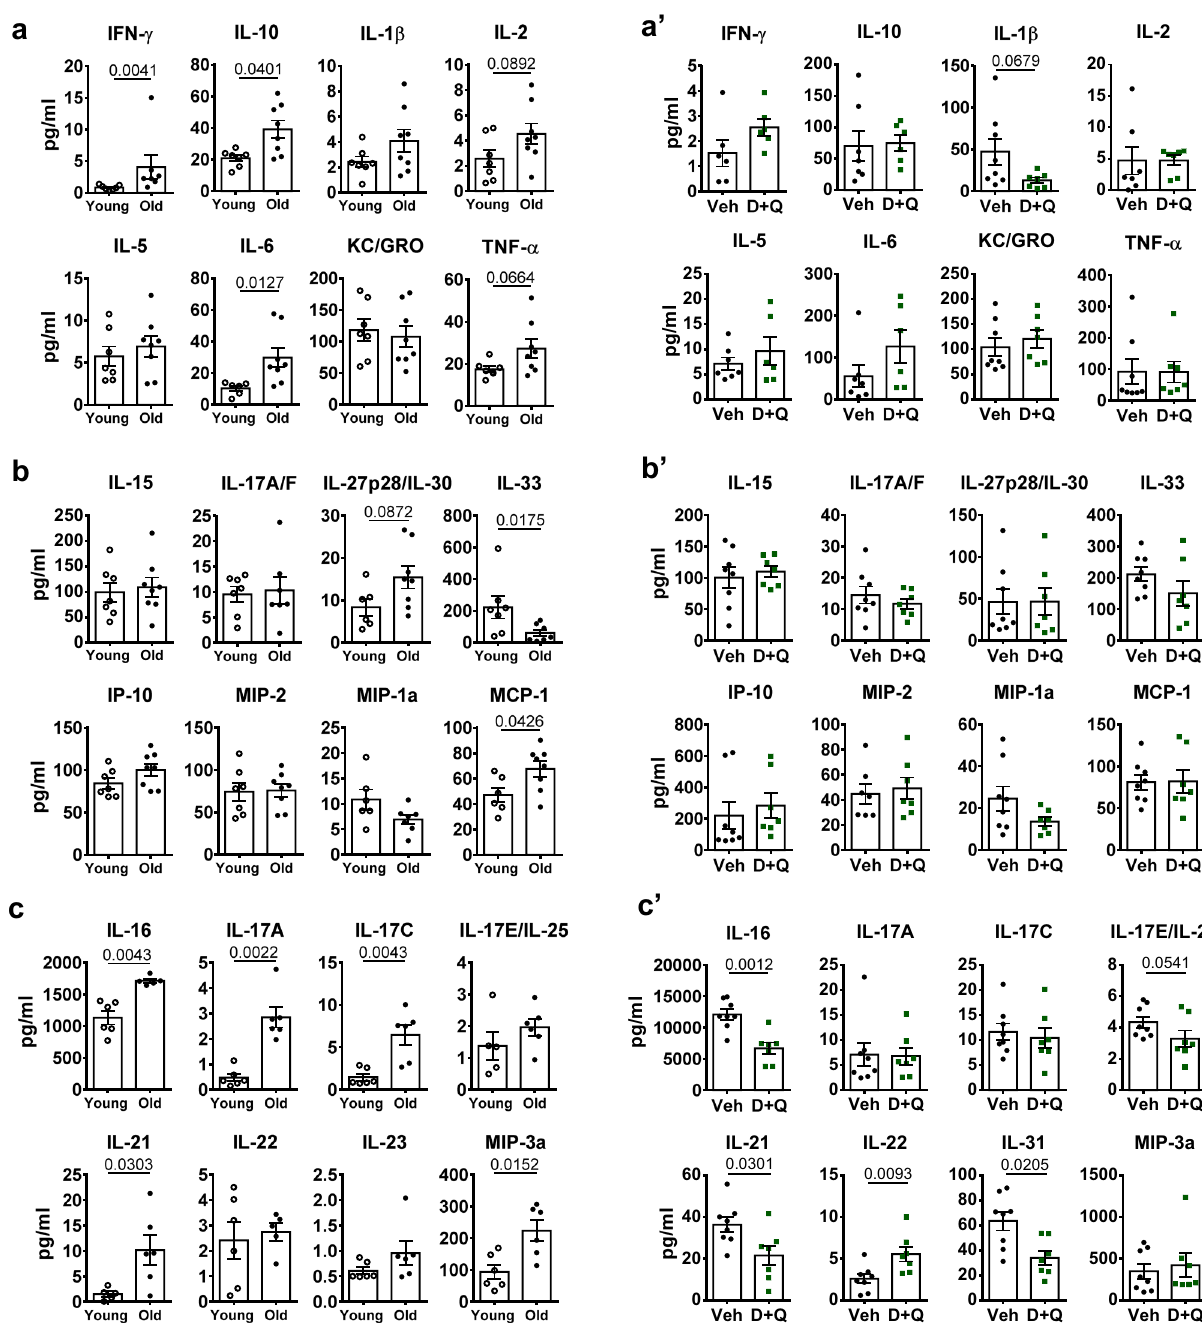
Fig. 7 D + Q treatment prevented the age-associated systemic increase in proin fl ammatory molecules, cytokines, and Th17-related proteins. Multiplex analysis of the main ( a – a ’ ) proin fl ammatory molecules, ( b – b ’ ) cytokines, and ( c – c ’ ) Th17-related proteins in plasma of young (6 – 12 M, n = 7), old (23 M, n = 8), Veh-14 – 23 M ( n = 8), and D + Q-14 – 23M ( n = 7) groups. Two-tailed t -test or Mann – Whitney test were used as appropriate. Data are represented as mean ± SEM. Source data are provided as a Source Data fi treatment duration cohorts (Supplementary Fig. 11a, b). Note- worthy, unlike in the intervertebral disc, immunohistochemistry analyses of senescence markers p16 INK4a , p19 ARF , and p21 in the knee joints did not show any differences between 14 and 23 M Veh- and DQ-treated mice (Supplementary Fig. 11c – e ” ). Taken